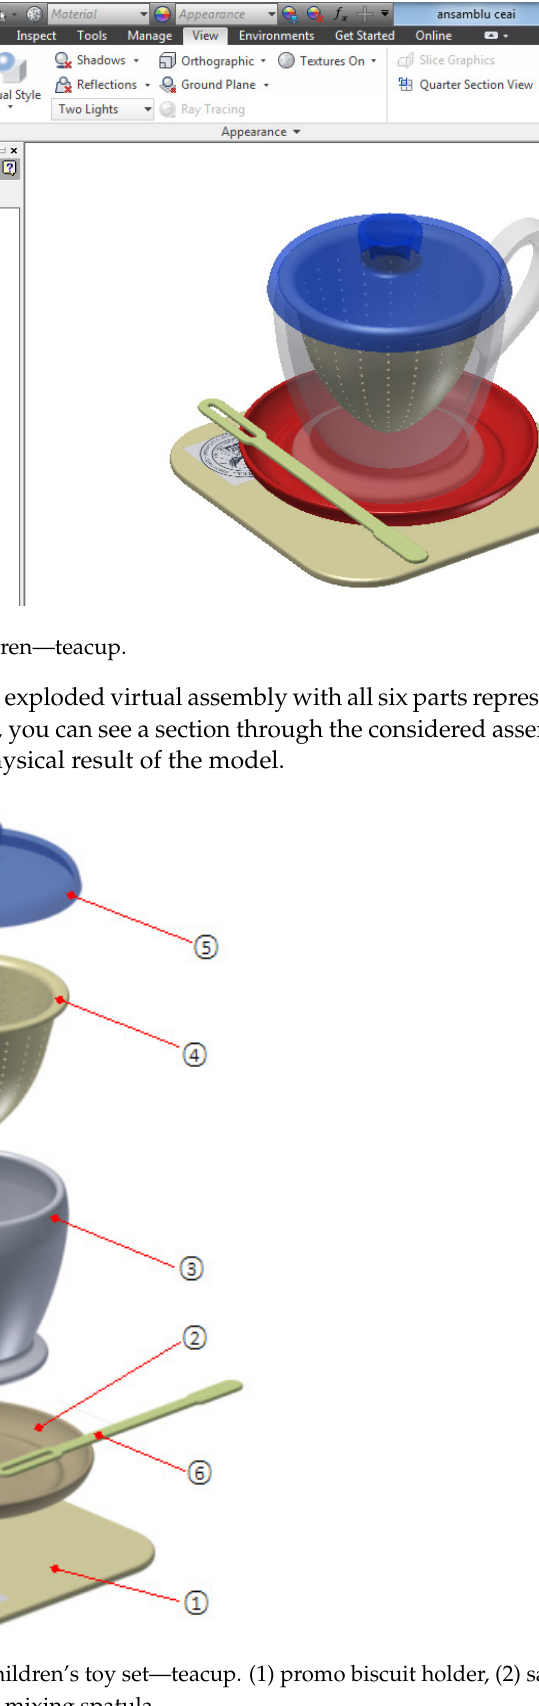
Figure 7. Generating 3D modeling in the Inventor environment.